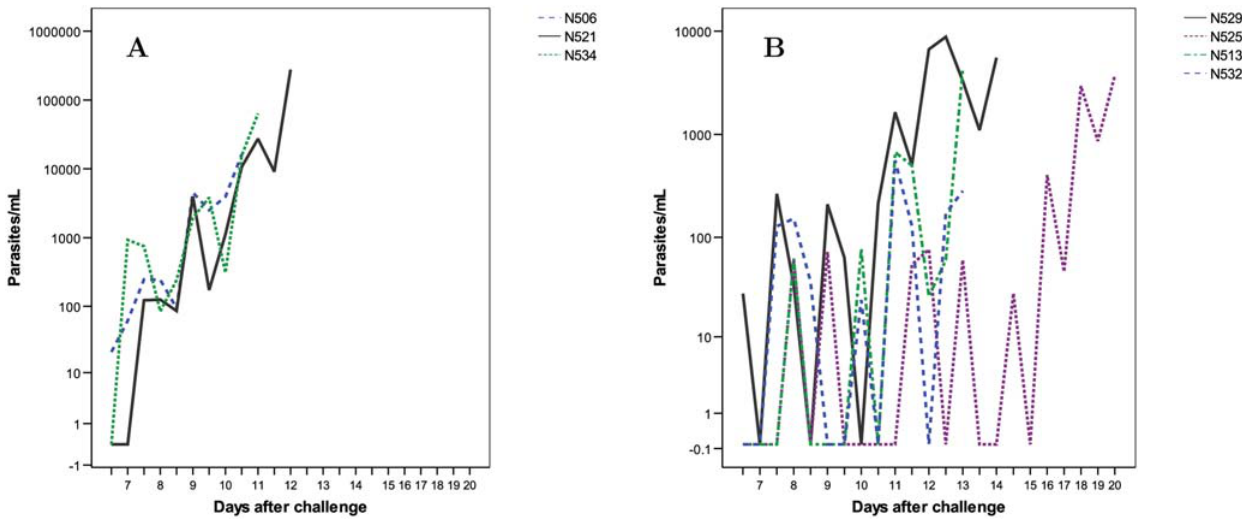
Figure 7. PCR data. Number of parasites per mL, estimated using a calibration curve, plotted by day post sporozoite challenge. A. Three volunteers selected to demonstrate expected pattern of PCR results: an exponential increase in the numbers of parasites over time, with some cycling seen as parasites are sequestered and released. B. This figure shows data from all 4 volunteers who had unusual PCR results. Up to 150 parasites/mL are detected, and are subsequently undetectable for one or more time points, before they are measured again. This pattern occurs several times, up to a